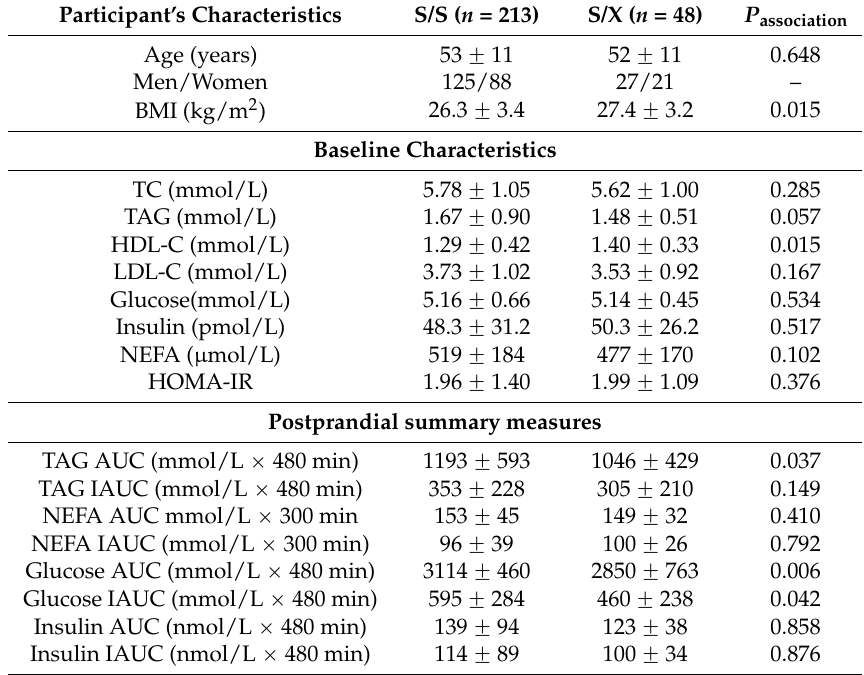
Table 1. Baseline and postprandial characteristics of the participants according to LPL-S447X